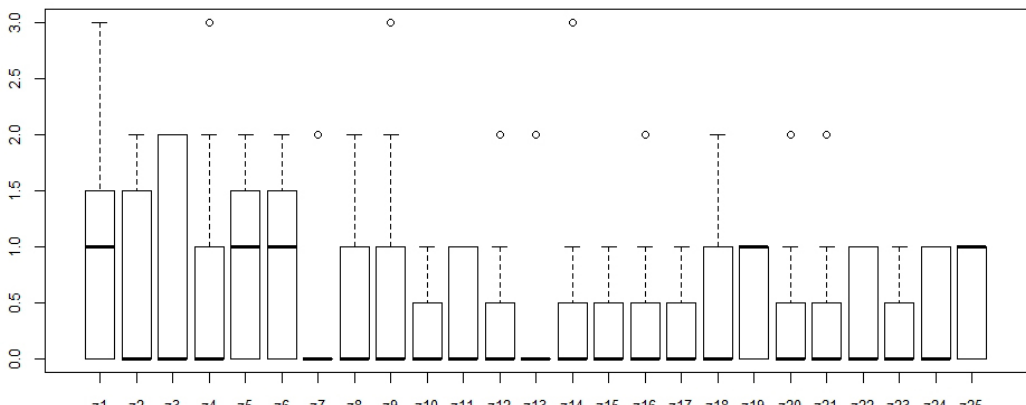
Fig. 2. Boxplot of weak links numbers of tested wrestlers (n = 25).